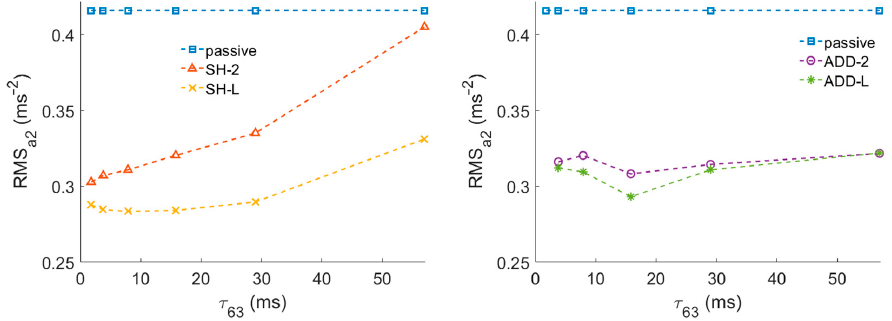
Figure 8. Course of v 2 –carbody lateral velocity from the model, v 2 − v 1 damper piston velocity from the model, I –measured electric current in damper, F c –measured damper force, for SH-L control (left) and ADD-2 control (right), HILS results.